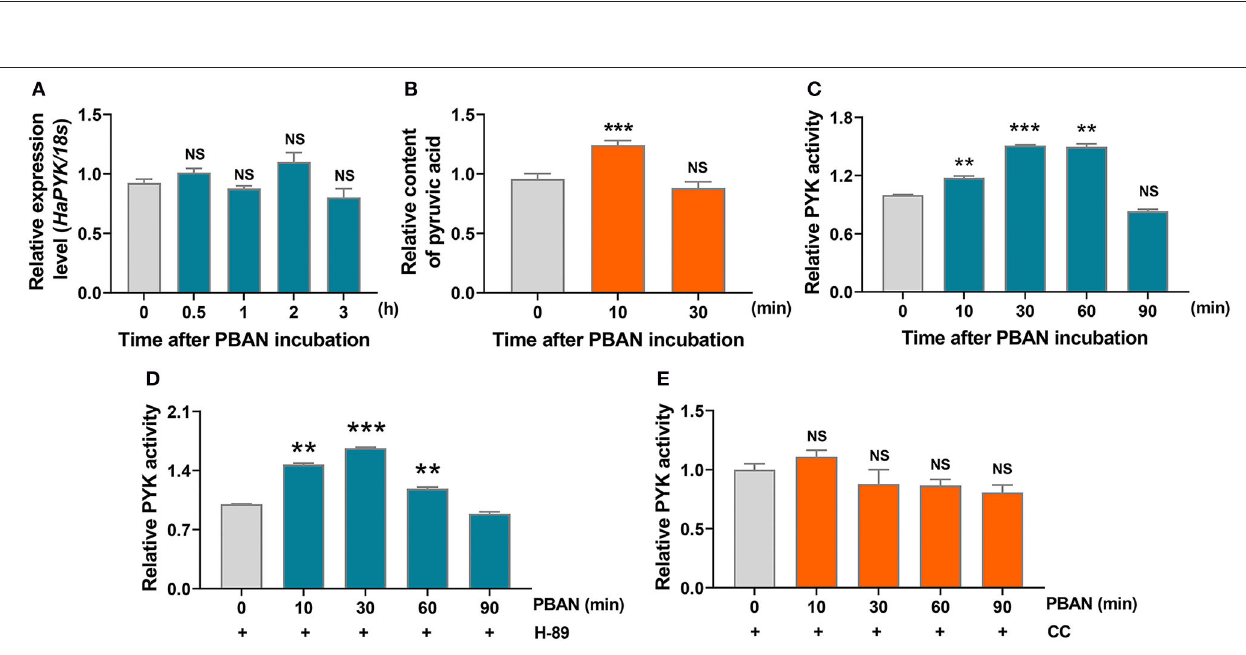
Frontiers in Physiology |